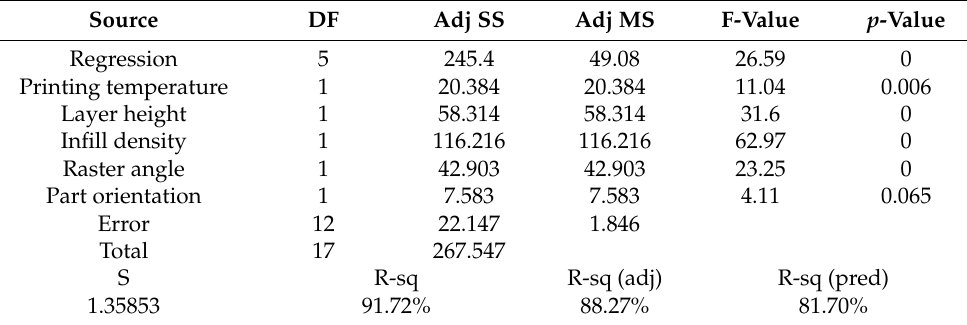
Figure 16. Deformed specimen after flexural test. Table 7. Flexural test response